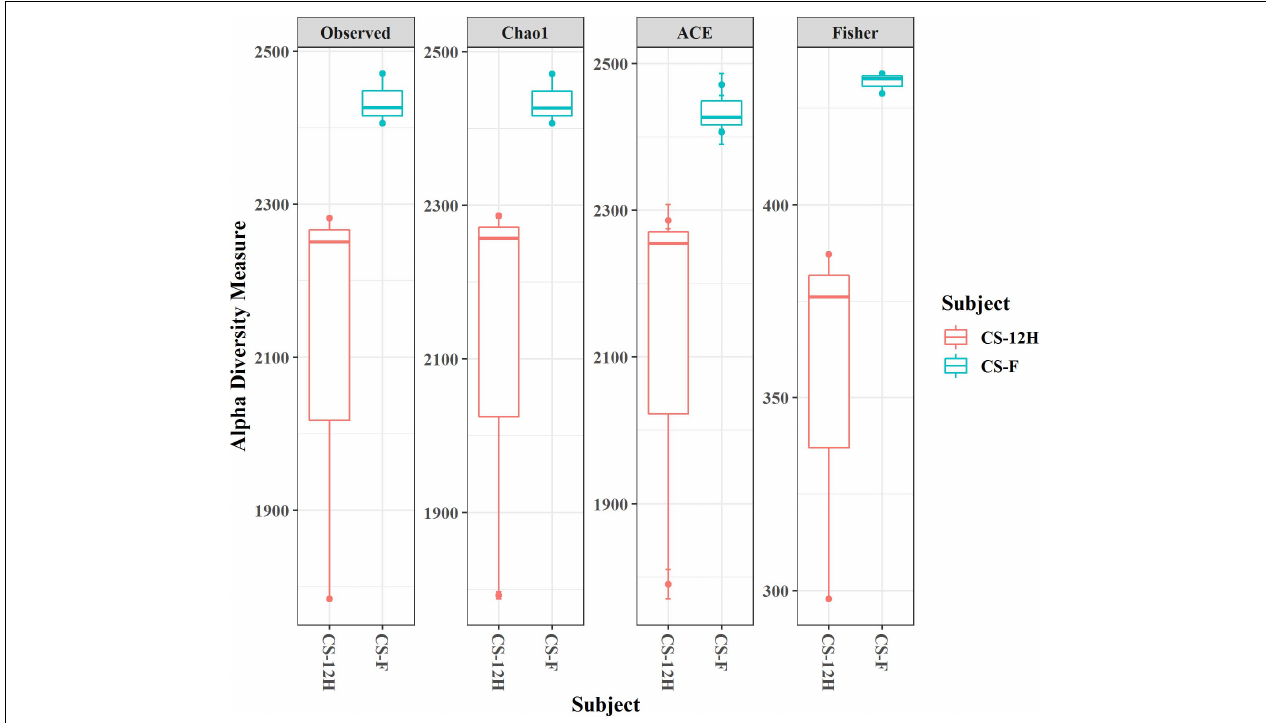
FIGURE 2 | Alpha diversity indices (for observed, Chao1, ACE, and Fisher measures) for bacterial reads in fresh (CS-F) and fermented (CS-12H) Kalparasa